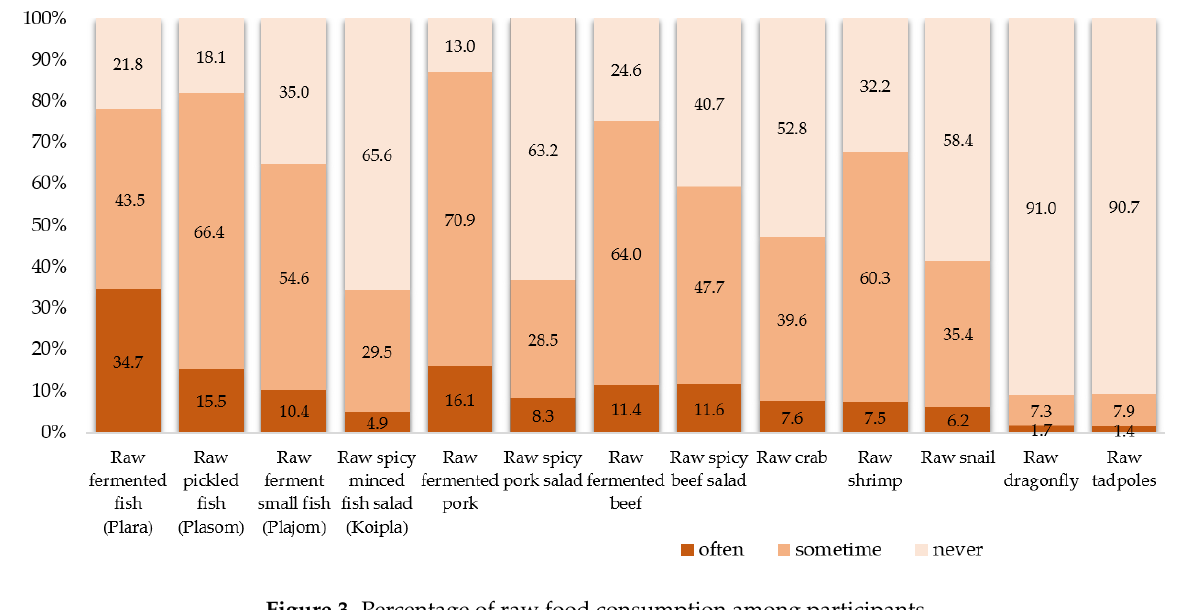
Figure 3. Percentage of raw food consumption among participants.